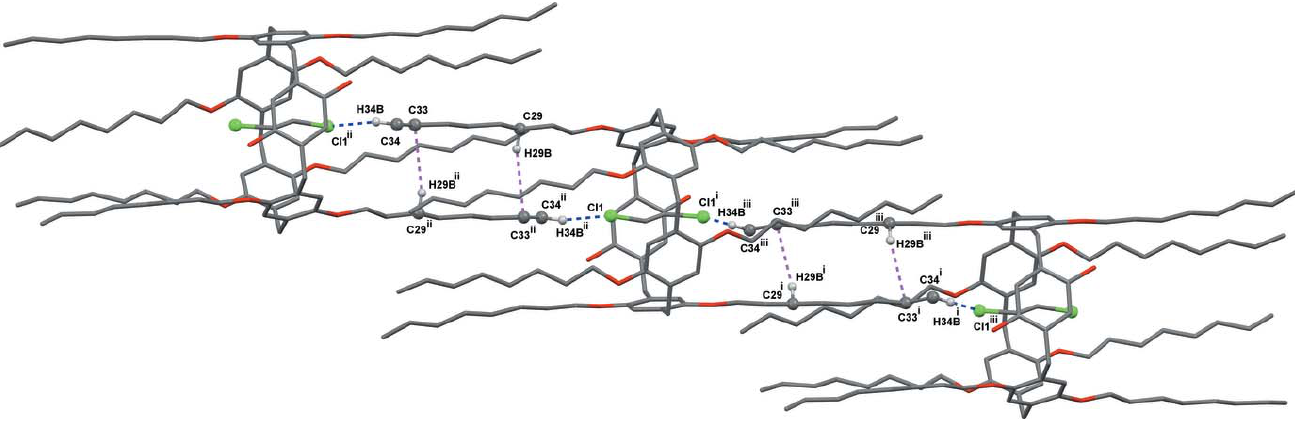
Figure 2 Supramolecular propagation of Pil-OctOH moieties as one-dimensional chains mediated by dichloroethane molecules via C—H (cid:2)(cid:2)(cid:2) Cl and C—H (cid:2)(cid:2)(cid:2) C interactions. C—H (cid:2)(cid:2)(cid:2) Cl interactions are represented in blue and C—H (cid:2)(cid:2)(cid:2) C interactions in purple. [Symmetry codes: (i) (cid:3) x + 1, y , (cid:3) z + 1 (cid:3) y + 3